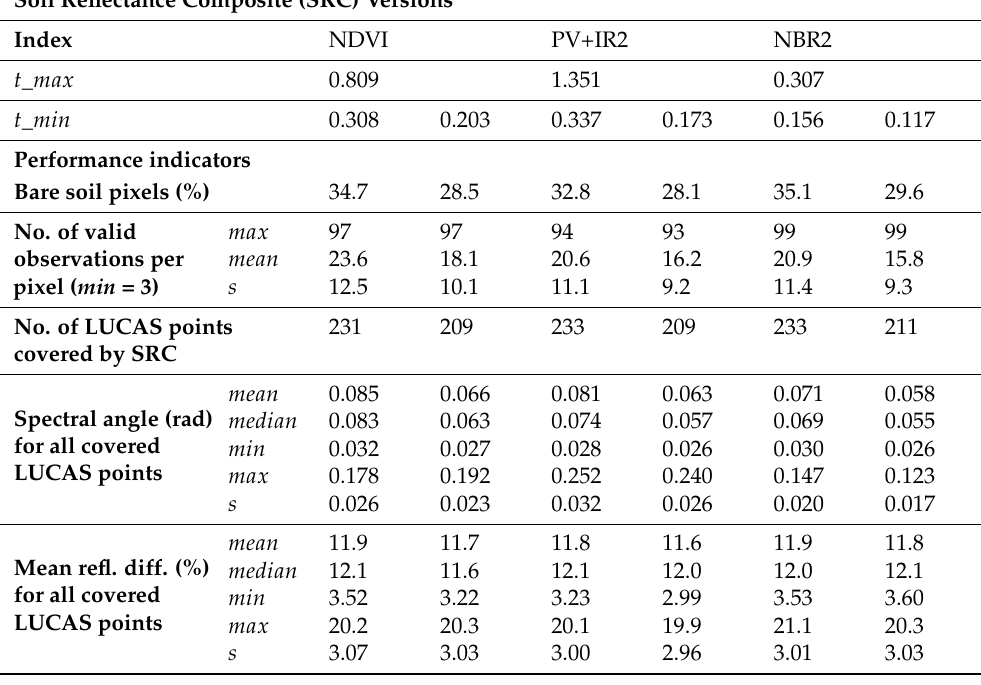
Table 3. Performance assessment of soil reflectance composites (9 tiles = 95,964 km 2 ) generated with varying t _ min ; s = standard deviation.